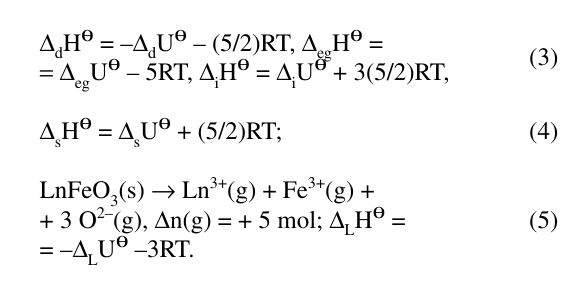
Table 1. Born – Haber cycle for lanthanide orthoferrites, LnFeO No Equation of the process in each